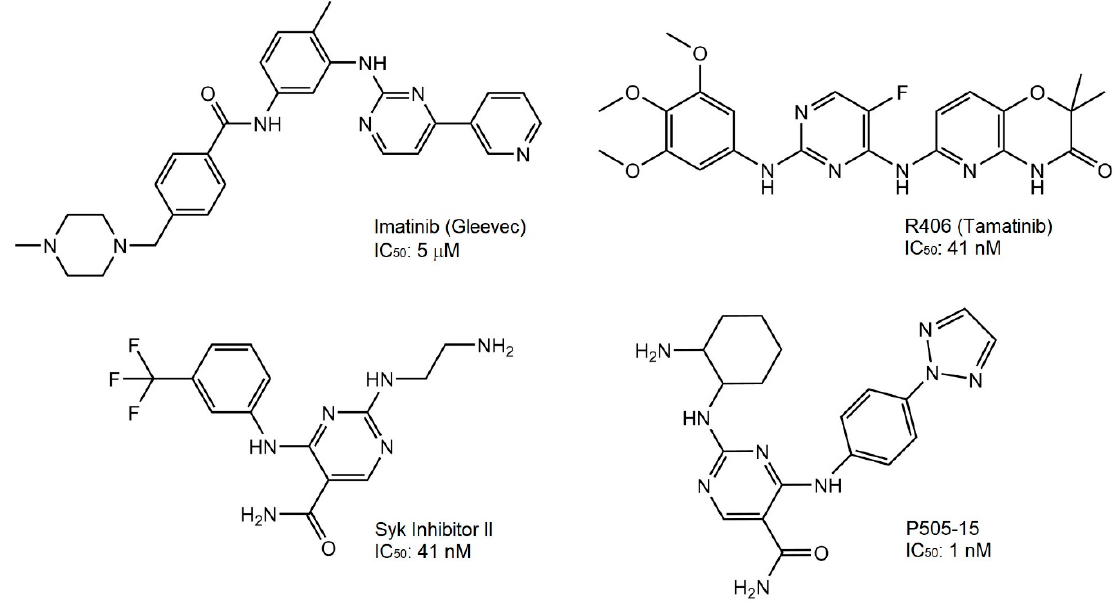
Figure 1. Chemical structures and IC 50s for the Syk catalytics subunits of Imatinib, R406, Syk inhibitor II, and P505-15.